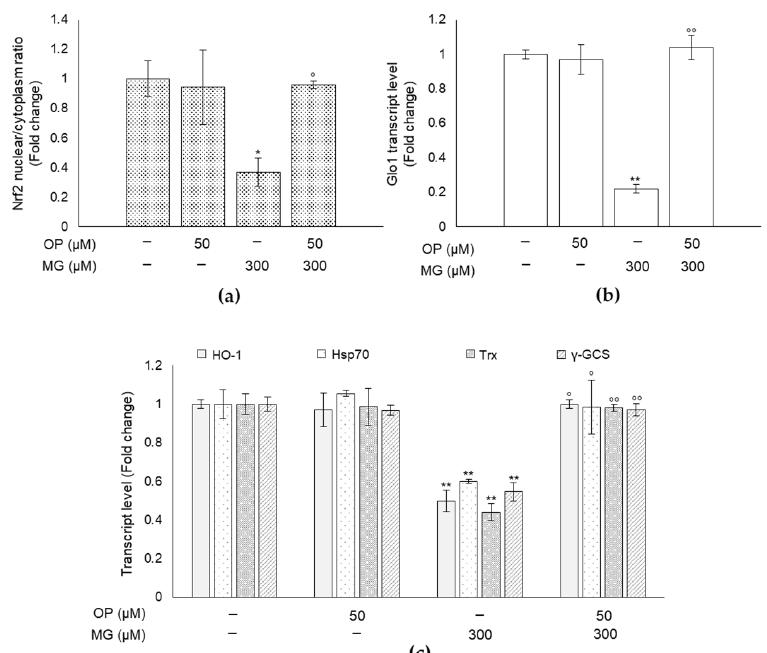
Figure 7. MG-induced responses and their prevention by OP are paralleled by changes of the master redox-sensitive transcriptional regulator Nrf2 in DPSCs. Nuclear and cytoplasmic extract of MG-treated DPSCs and controls were analyzed by ELISA to determine the activation of Nrf2. We observed that ( a ) the nuclear to cytoplasmic ratio of Nrf2 was significantly lower in MG-exposed DPSCs than in control cells and this decreased nuclear translocation of Nrf2 in MG-treated DPSCs was paralleled by ( b ) the downregulation of Glo1 mRNA. ( c ) Transcript levels of HO-1, Hsp70, Trx, and γ -GCS were determined after MG treatment for 24 h and in OP pretreated DPSCs. MG determined a down-regulation of HO-1, Hsp70, Trx, γ -GCS at mRNA level that was prevented in OP pretreated DPSCs Histograms indicate the means ± SD of three different cultures, each of which was tested in triplicate. * p < 0.05, ** p < 0.01 versus unexposed cells. ◦ p < 0.05, ◦◦ p < 0.01 compared to MG-treated